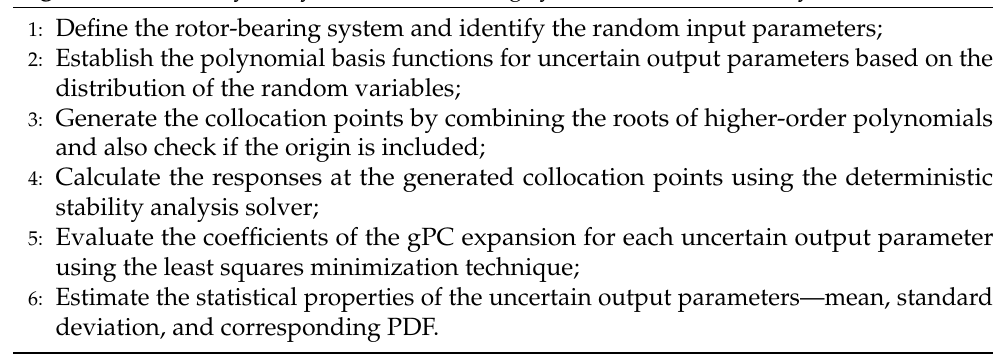
Algorithm 2 Stability analysis of rotor-bearing system under